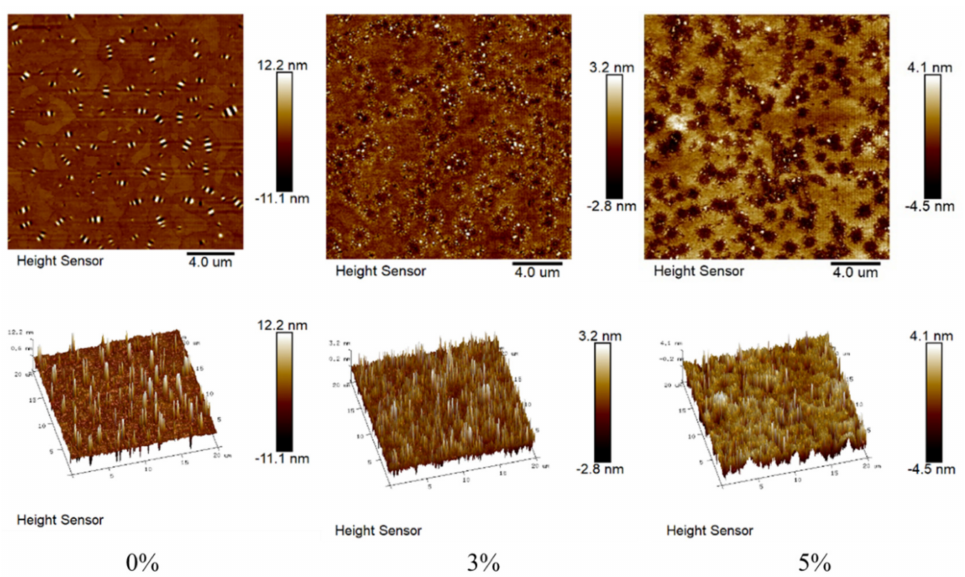
Figure 5. Microscopic characterization of AFM at different doping